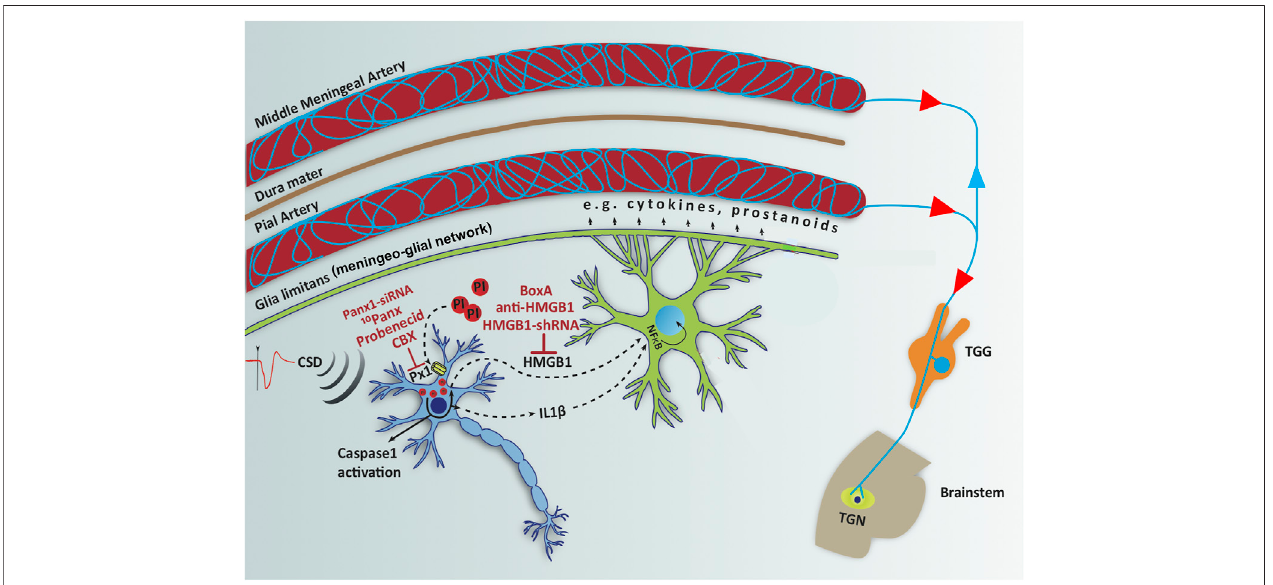
FIGURE2| OpeningneuronalPanx1channelsafterCSDinitiatesaneuroin fl ammatorysignalingcascade,characterizedbyin fl ammasomeformationandcaspase- 1 activation in neurons followed by release of HMGB1 and IL-1 β , which trigger NF- κ B nuclear translocation in astrocytes. Red labels show agents used to inhibit each step in the in fl ammatory cascade and red circles represent propidium iodide (PI) in fl ux through open Panx1 (Px1) large-pore channels. NF- κ B induces transcription of severalpro-in fl ammatorygenesincludingcytokinesandprostanoids,whicharethoughttobereleasedtoCSFthroughglialimitansandmeningeo-glialnetworkand activate the nociceptive nerves around pial and dural vessels, causing headache. Modi fi ed from Karatas et al., 2013 with permission.